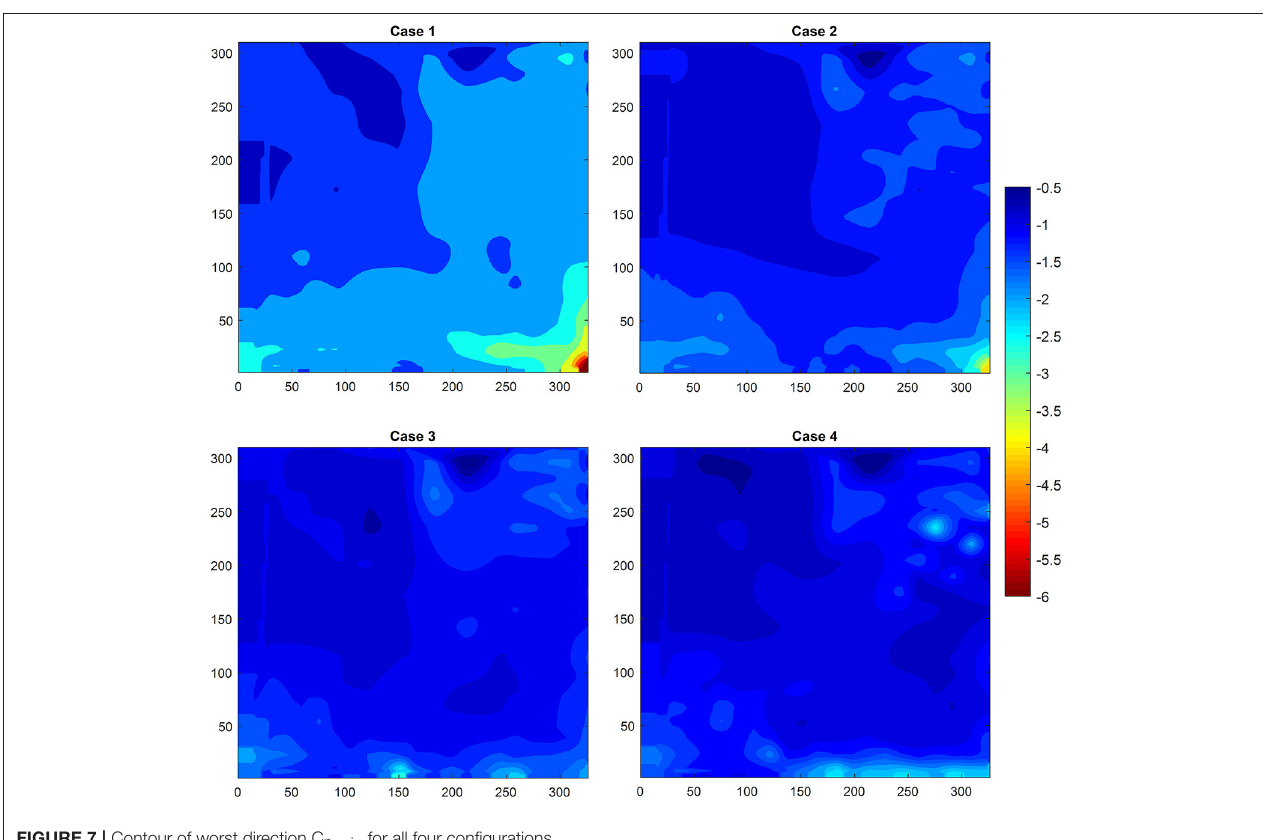
FIGURE 7 | Contour of worst direction C p min for all four configurations.